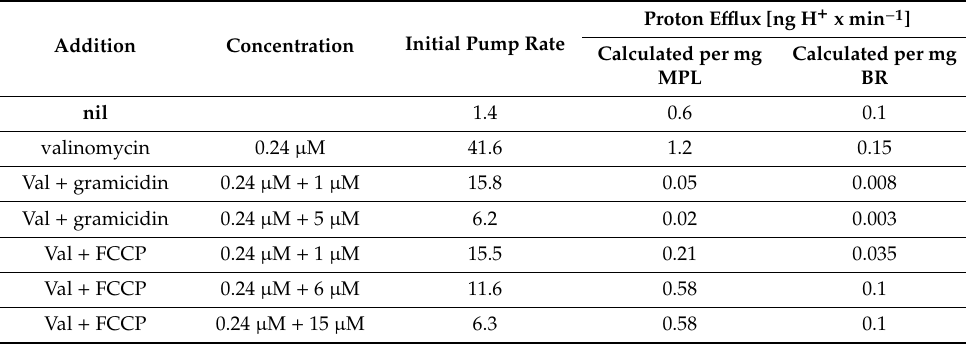
Table 14. E ff ect of valinomycin on proton pumping and proton e ffl